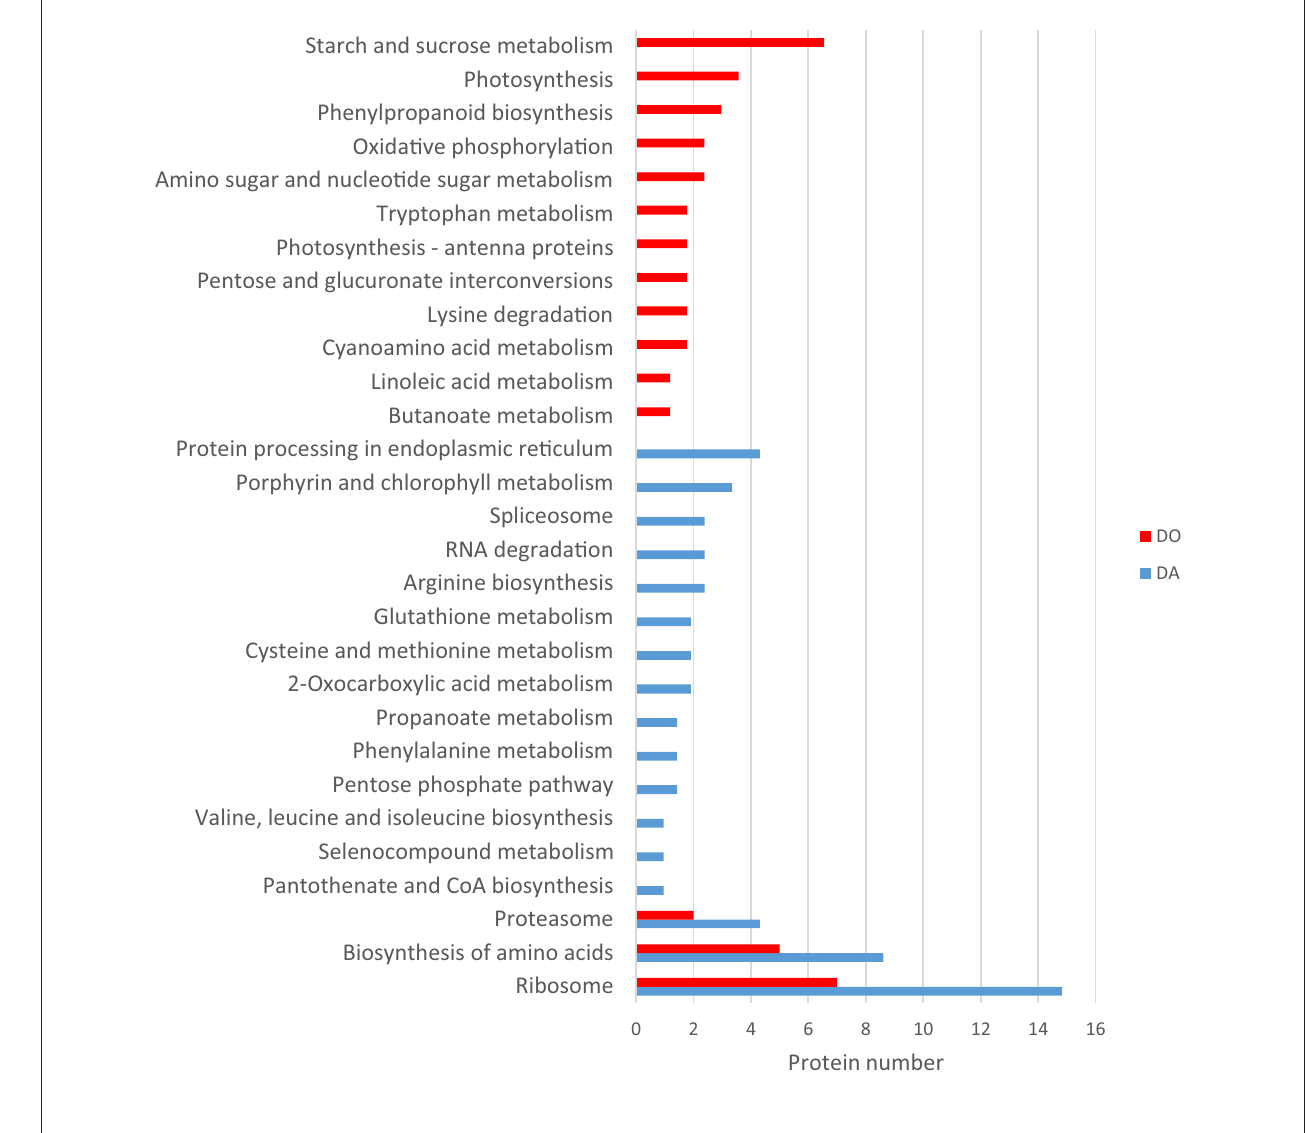
FIGURE 5 | KEGG classification of proteins differentially upregulated in the apogamous fern Dryopteris affinis and its sexual relative D. oreades .